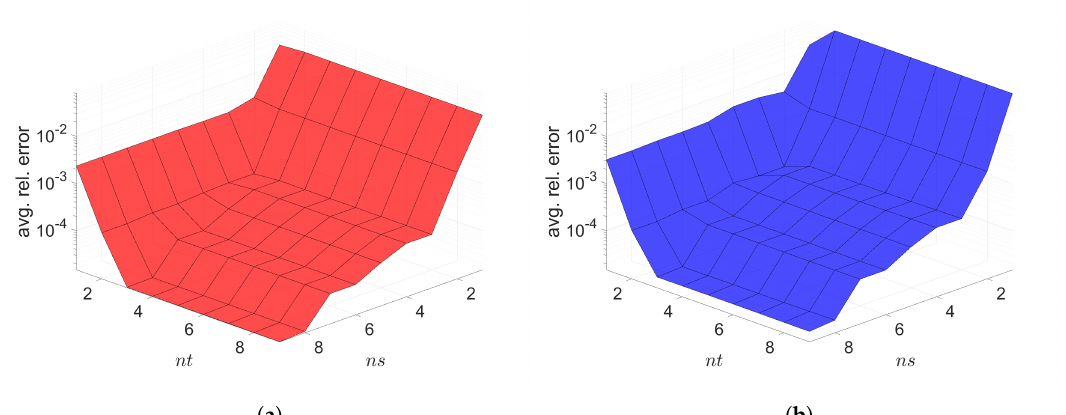
Figure 4. 2D linear diffusion equation. Relative errors vs. reduced dimensions. Note that the scales of the z -axis, i.e., the average relative error, are the same both for Galerkin and LSPG. Although the Galerkin achieves slightly lower minimum average relative error values than the LSPG, both Galerkin and LSPG show comparable results. ( a ): Relative errors vs. reduced dimensions for Galerkin projection, ( b ): Relative errors vs. reduced dimensions for LSPG